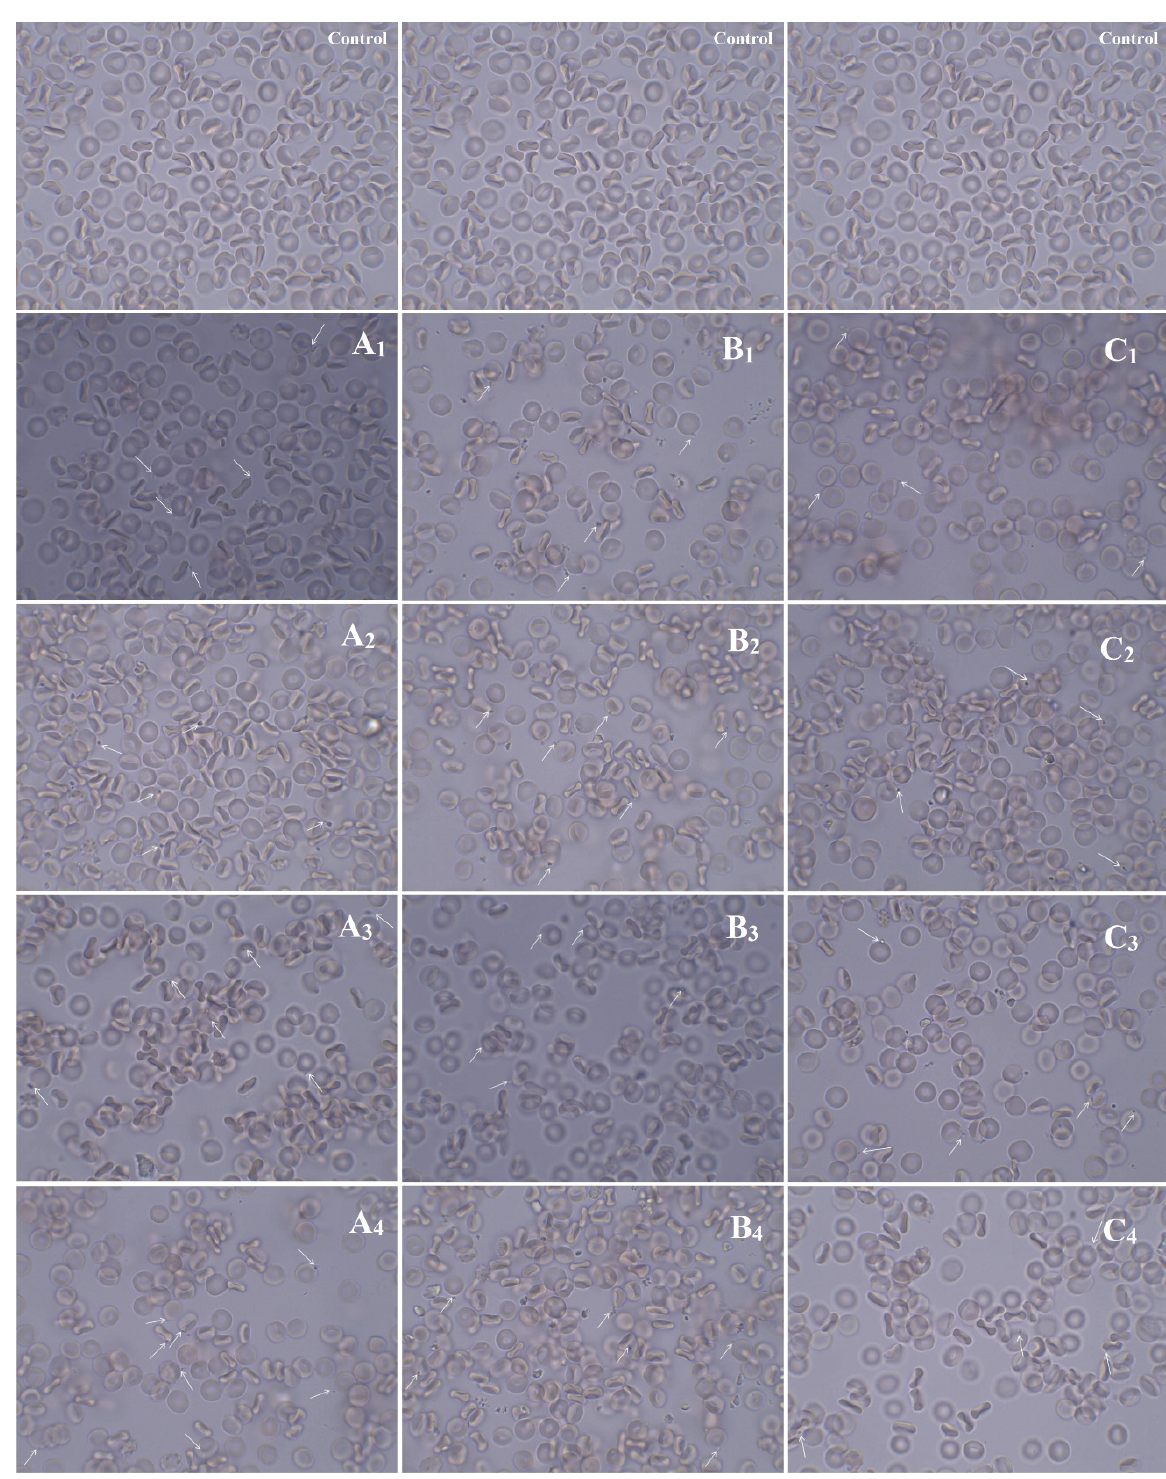
Figure 12. Effect of the nanoapatites (1 mg/mL): HAp ( A 1 ), ClAp ( B 1 ) and FAp ( C 1 ) as well as nanoapatites doped with Li + ( A 2 , B 2 , C 2 ), doped with Eu 3+ ( A 3 , B 3 , C 3 ) and co-doped with Eu 3+ /Li + ions ( A 4 , B 4 , C 4 ) on the human erythrocyte morphology observed in the light microscopy (60 min, 37 °C) at 100× magnification with immersion oil (10× ocular). Control – cells incubated in PBS buffer. The cells were fixed in a mixture of PFA 5% and GA 0.01%, rinsed 3× in PBS and closed in glycerol. Scale bar in control images is representative for all images presented: 10 µm. Arrows indicate slight aggregates of nanoapatites attached to the RBCs’ membrane.